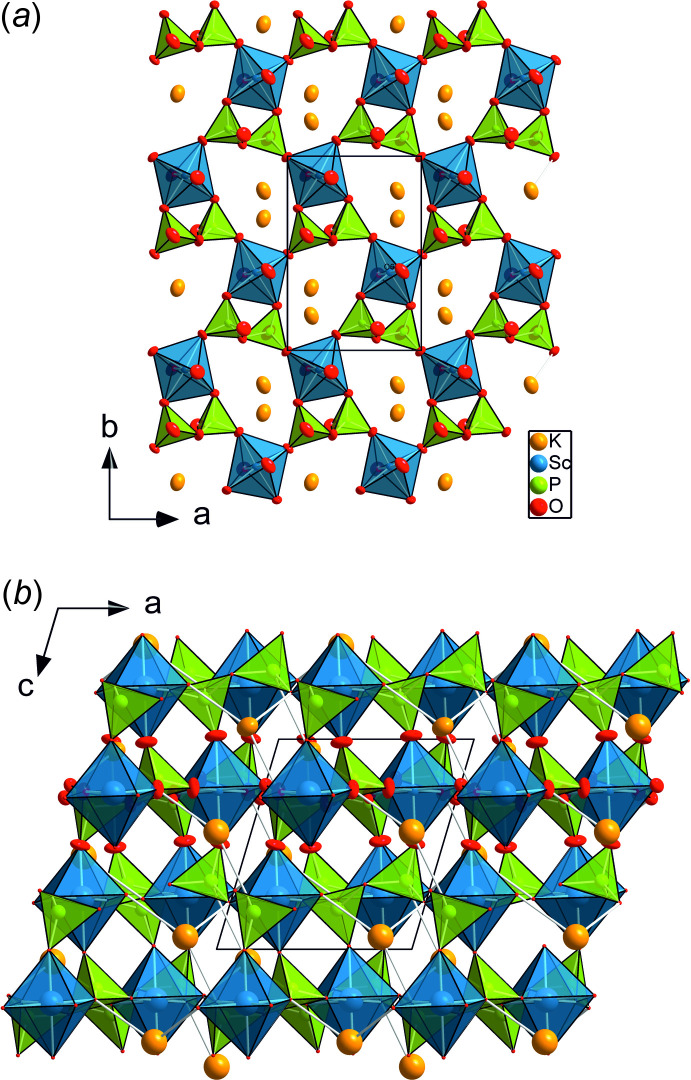
(a) Layer of laterally inter­connected {ScP2O11}9− units, forming a layer parallel to (001), the KI cations are hosted in the channels extending along [001]; (b) the three-dimensional framework structure of KScP2O7, viewed along [010].